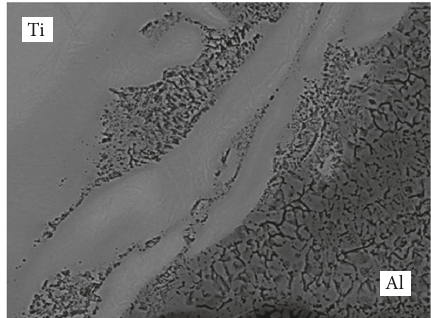
Figure 20: Microstructure of aluminium AW 5754 alloy and Ti Grade 2 weld metal.